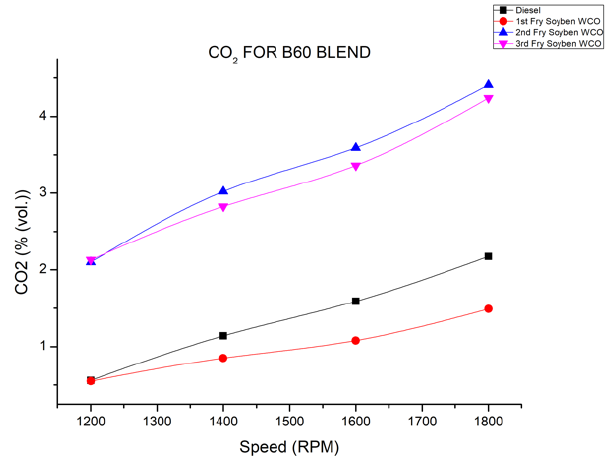
Figure 6. CO 2 emission of different fry oils (B60 blend) at different rpm.